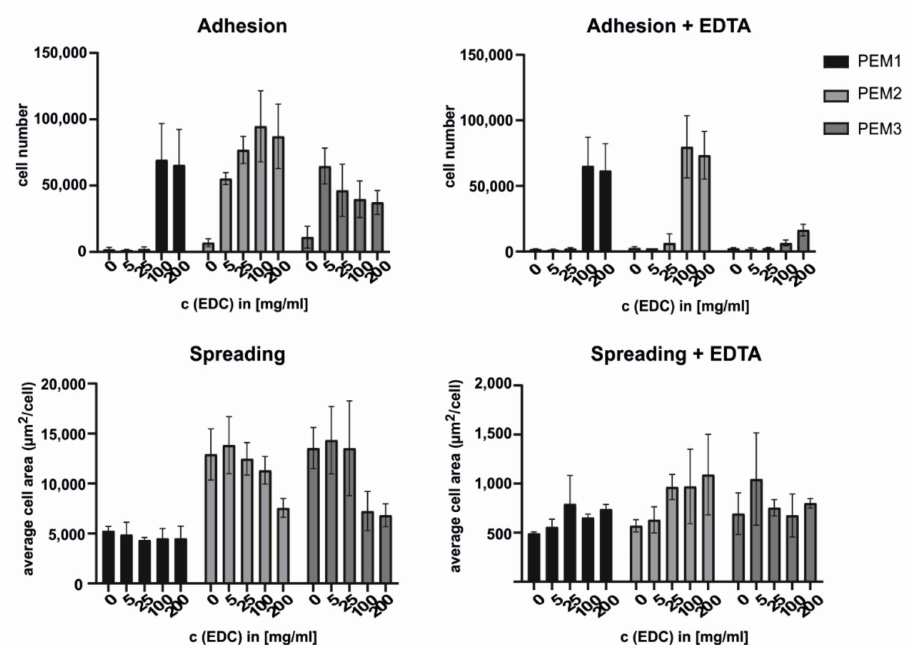
Figure 10. Adhesion and spreading of MC3T3 cells on different PEM films cross-linked with different EDC concentrations. Adhesion and spreading experiments were conducted with or without EDTA in the medium. The EDTA was supplemented in the medium to inhibit integrin-mediated binding to